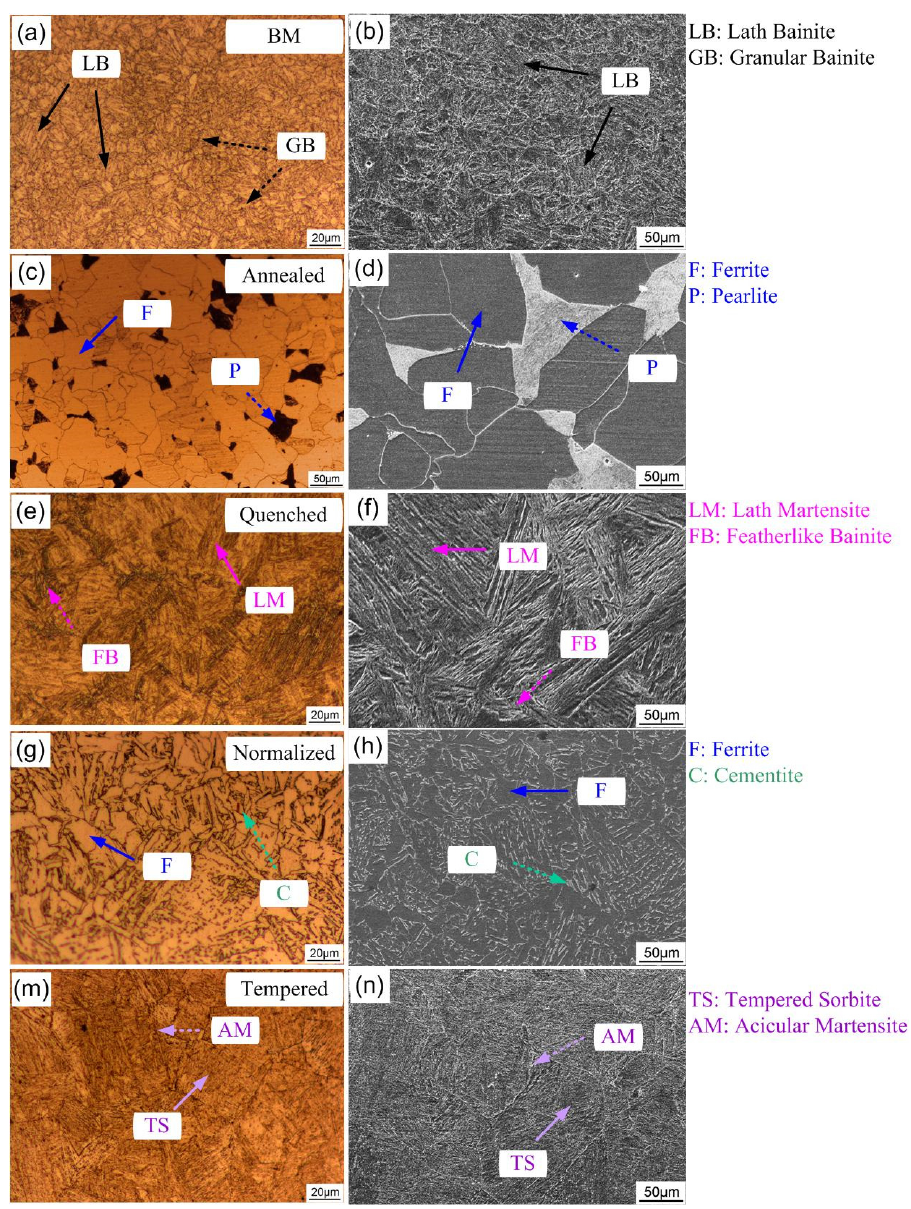
Figure 2. Microstructure characteristics of steel base metal ( a , b ), annealed steel ( c , d ), quenched steel ( e , f ), normalized steel ( g , h ), and tempered steel ( m , n ) observed by light microscope ( a , c , e , g , m ) and scanning electron microscope (SEM) ( b , d , f , h , n ).